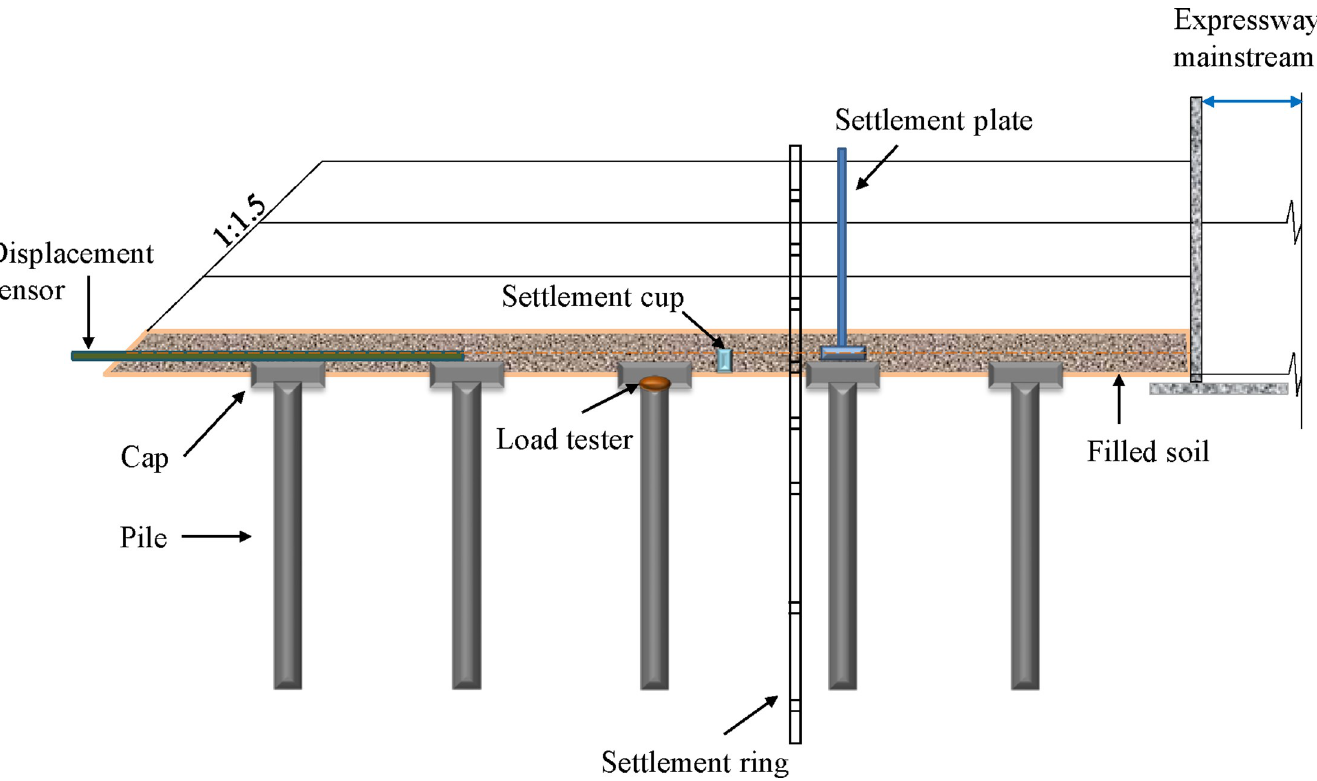
Fig 8. GRPSE system monitoring section and point layout